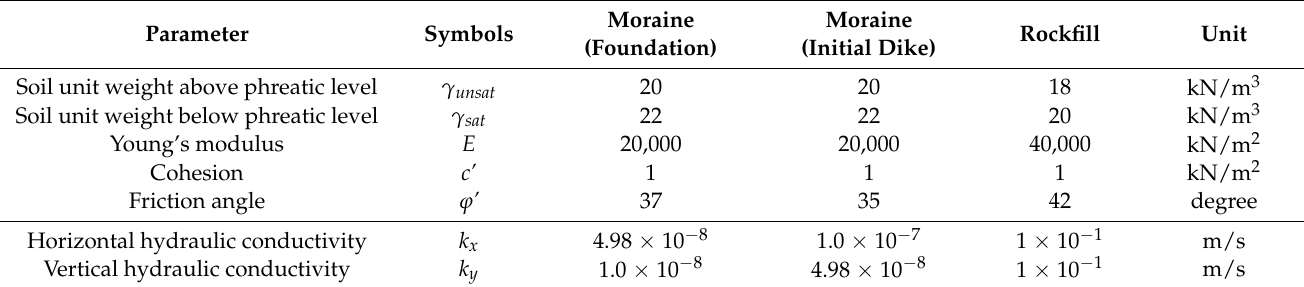
Table 1. Parameters of Mohr–Coulomb (M-C) model.